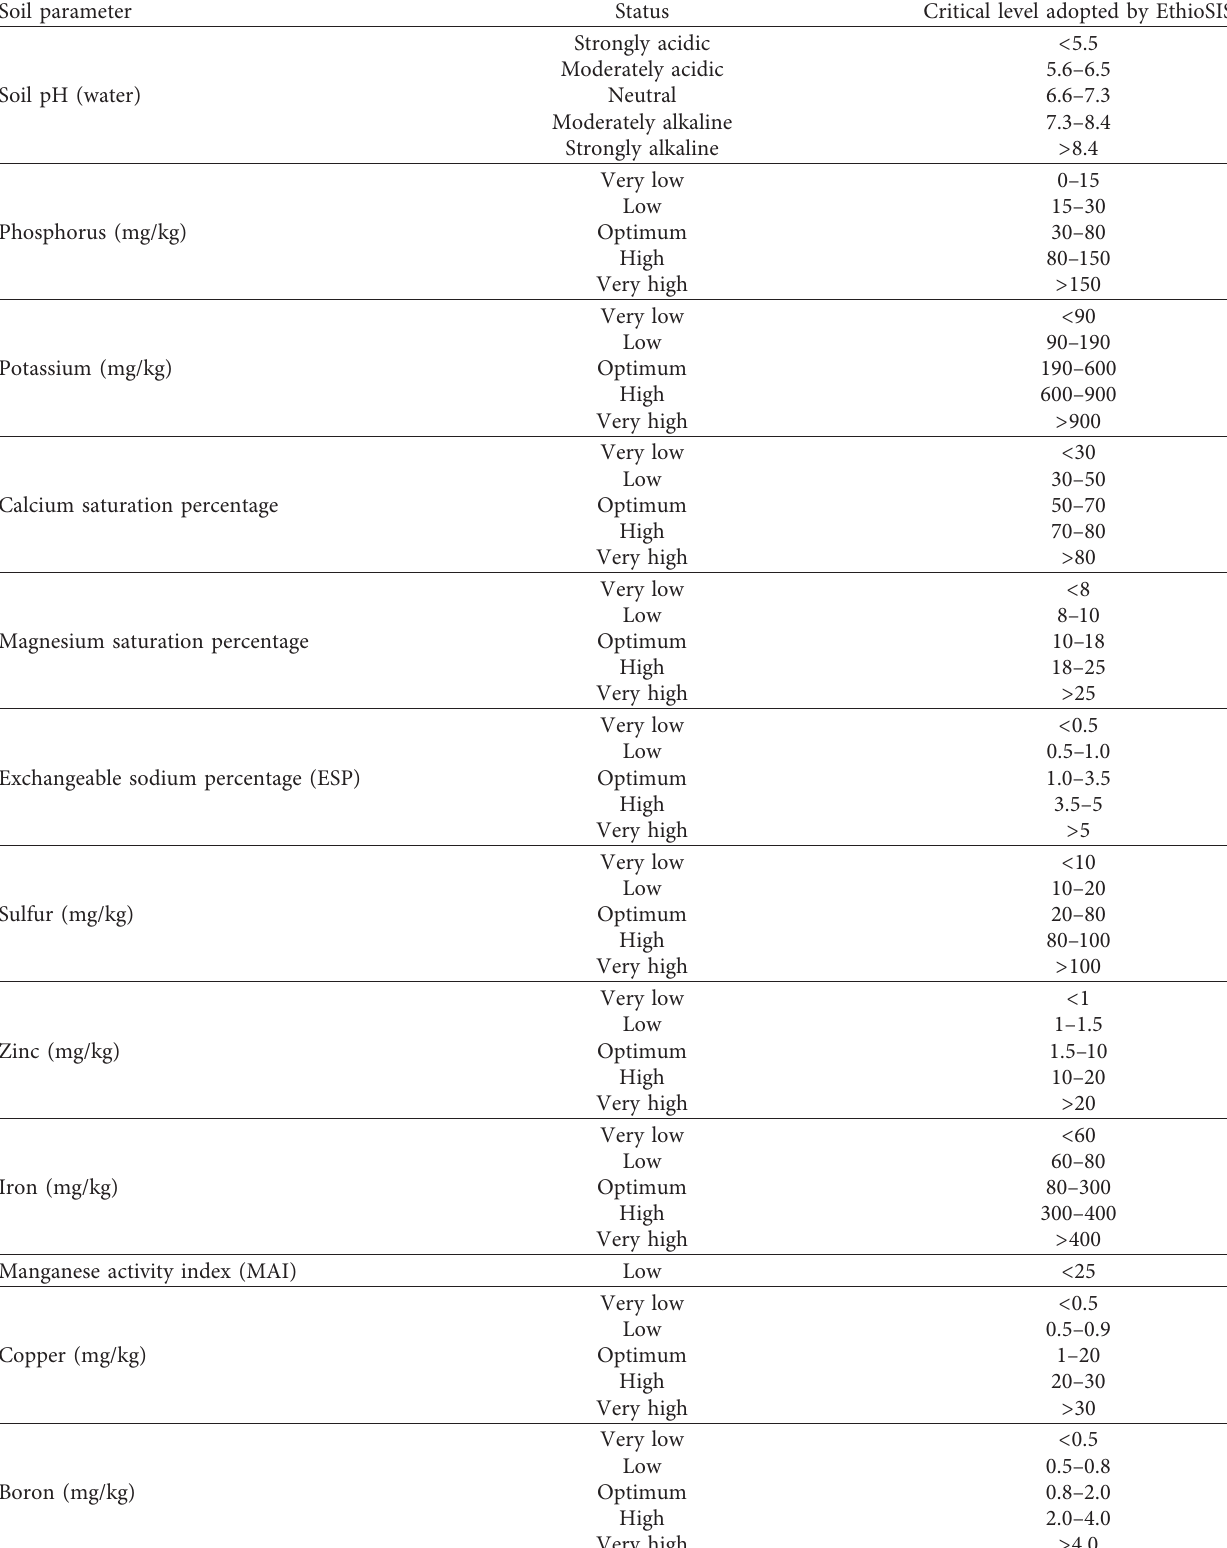
Table 4: Critical levels used for classifying soil fertility analysis results in Ethiopia